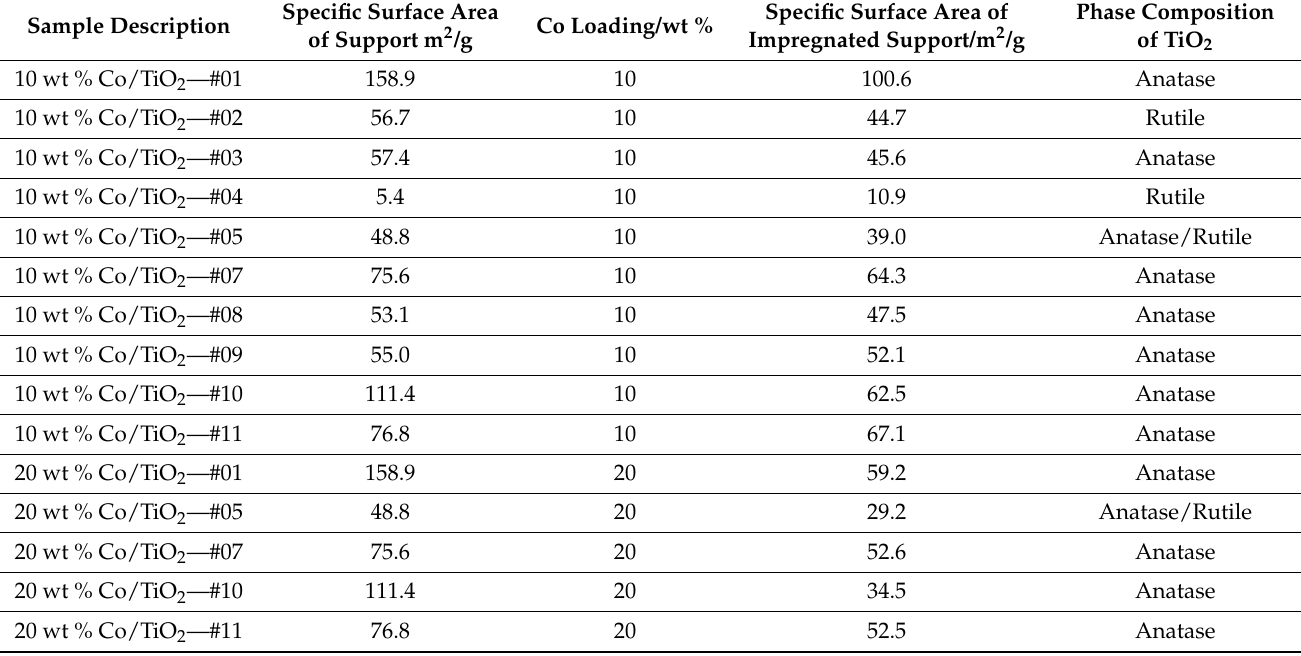
Table 2. Overview of supported Co catalysts on different TiO 2